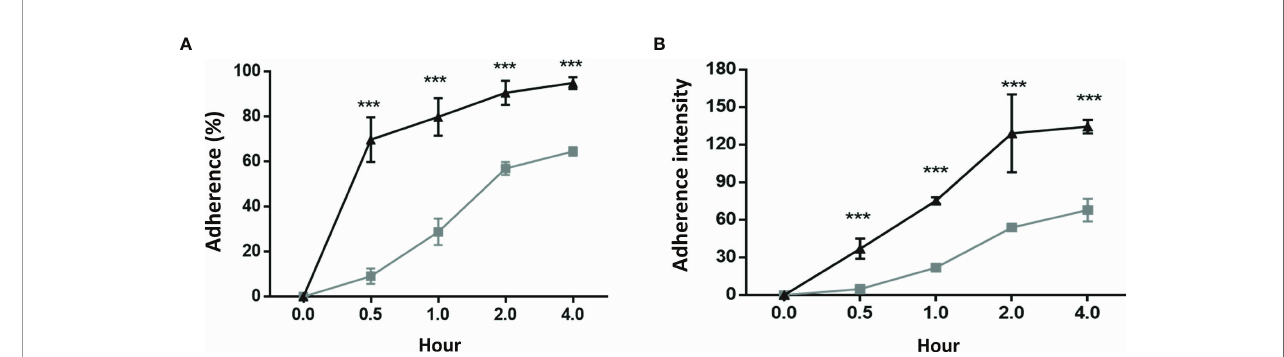
FIGURE 2 | H. pylori colonization rate and intensity between GES-1 and HSFE cells over time. GES-1 (black triangles) and HSFE (gray squares) cells were challenged with H. pylori (MOI 100) for 0, 0.5, 1, 2, and 4 hours. The cells were washed thrice with PBS to remove unadhered H. pylori. The adherent rates of H. pylori (A) percentage and (B) intensity were detected using speci fi c antibodies by fl ow cytometry. Data are expressed as means ± SD (in triplicate). Statistical analysis was performed for each measurement with comparisons with the HSFE cells at each time period (*** P <